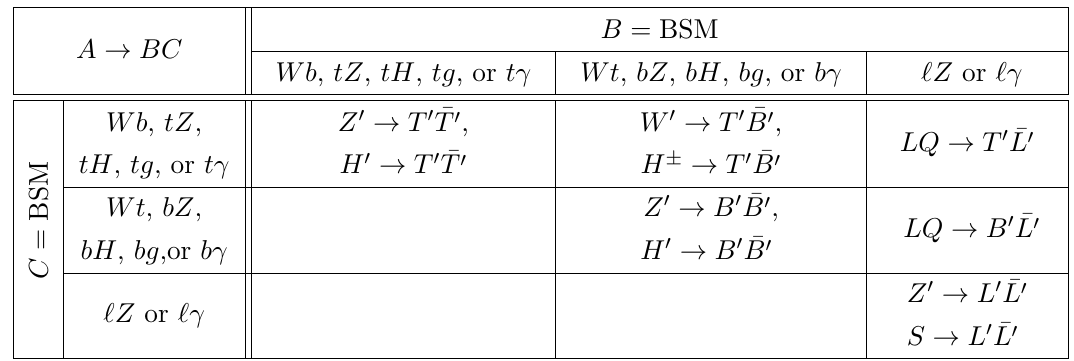
Table 8 . Example (Group VIII in table 1) for A ! BC , where A , B , and C are BSM particles. Each of B and C decays to di(cid:11)erent kinds of SM particles. This table shows the resonant productions (via either a new gauge boson or a new scalar) of new